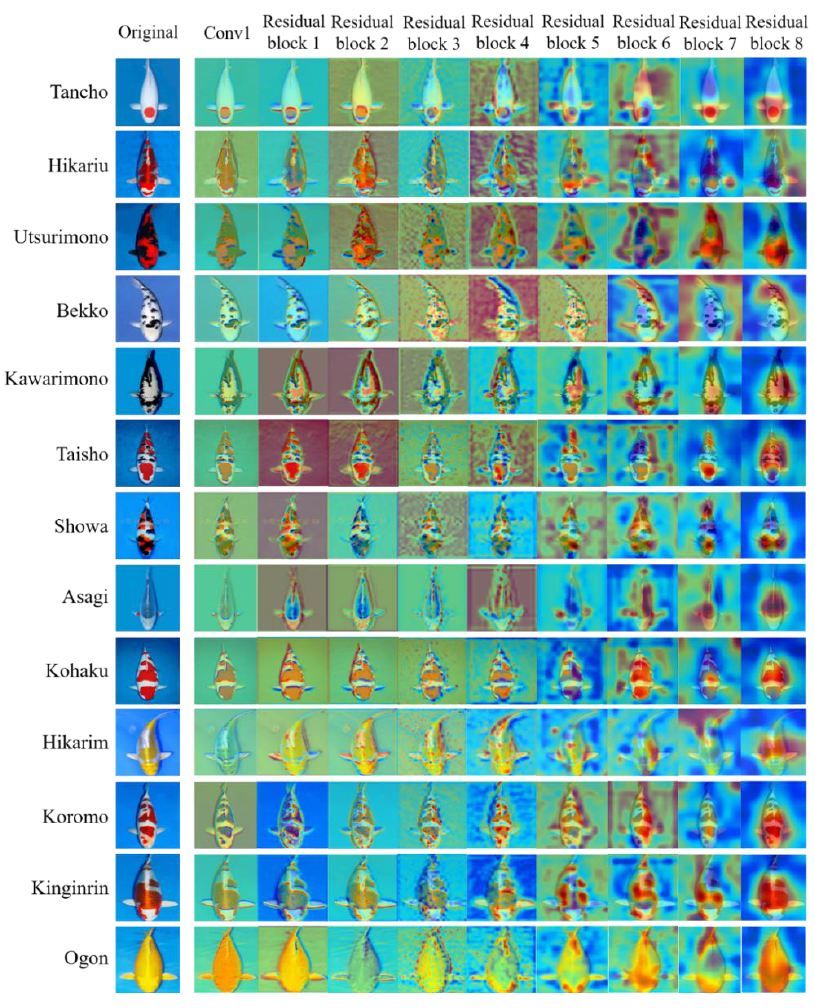
Figure 9. Grad-CAM visualization of KRS-Net.